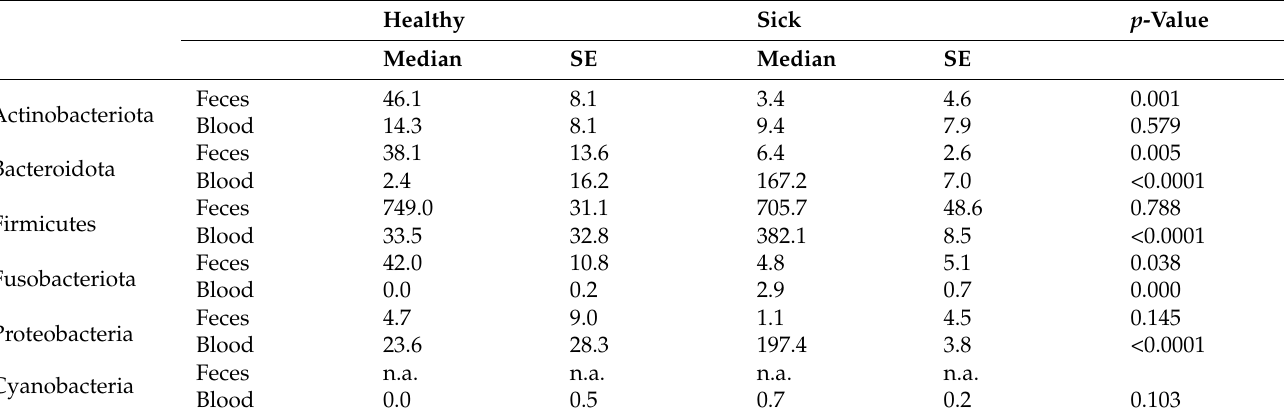
Figure 1. Composition similarity in the bacterial community at the genus level in blood and feces of healthy ( A ) and sick ( B ) dogs. Core genera are defined as genera that are found in both groups of dogs. Table 1. Kruskal–Wallis non-parametric test of the relative abundances (RAs) of the phyla characterizing the fecal and the blood microbiome of healthy and sick dogs. Mean and standard deviation (SD) are reported. p -value below 0.05 denotes significant differences of the means.